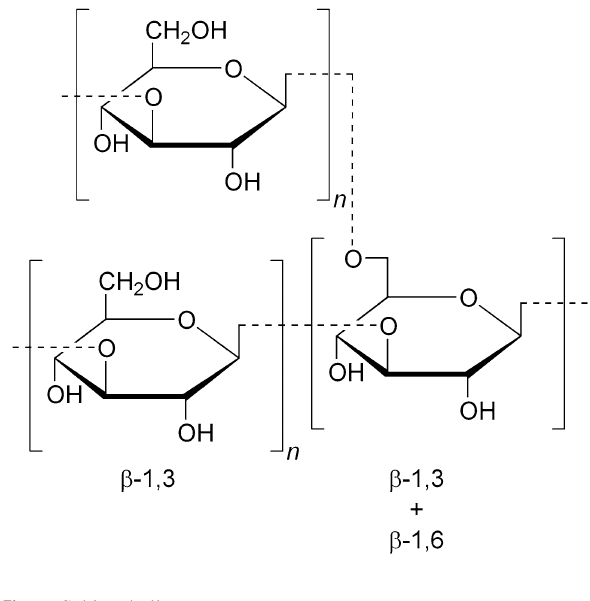
Fig. 2 Schizophyllan structure